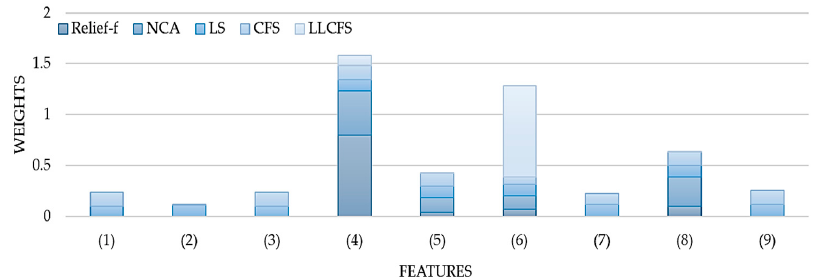
Figure 5. Weights from five feature selection algorithms after normalization.